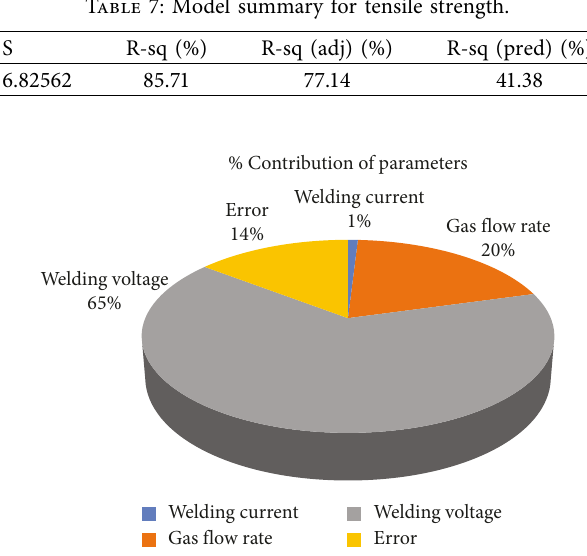
Figure 11: % contribution of parameters for tensile strength.